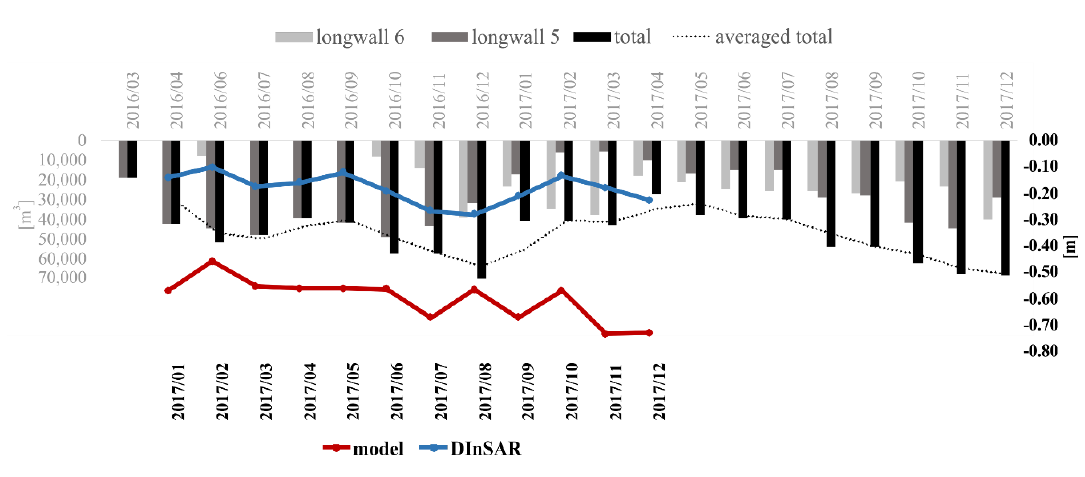
Figure 18. Amount of maximal subsidence by months detected by DInSAR (blue) and predicted from the model (red), compared with the estimated material extraction from coal seam 503. The black axis values on the right and bottom represent the subsidence and corresponding dates, respectively. The grey axis values on the left and above the graph relate to the amount of the extracted material and the time for these events.